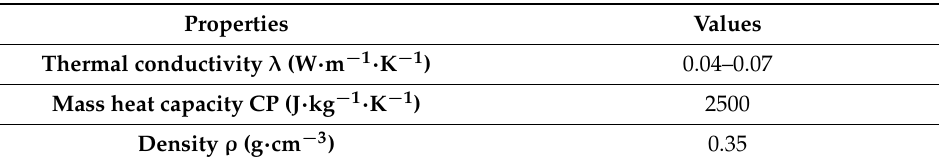
Table 2. Physical properties of Posidonia oceanica fibers.